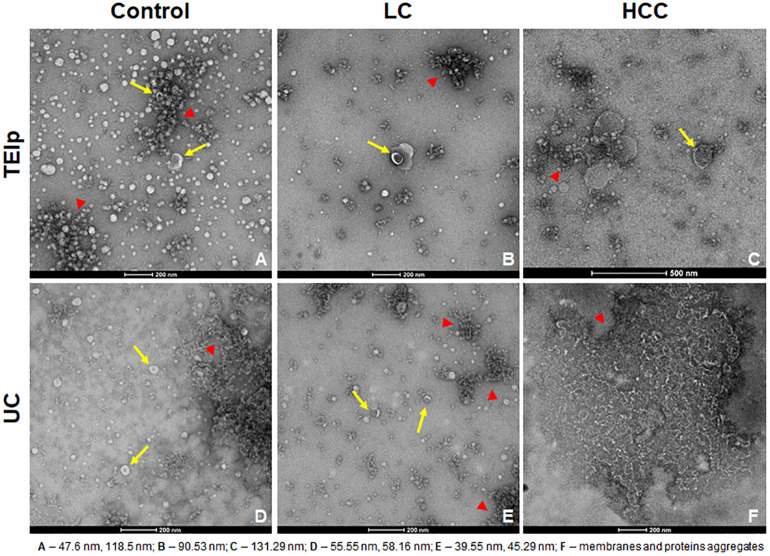
Gallery of negative stain digital micrographs showing cup-shaped exosomes with size ranging in between 40 and 150 nm (yellow arrows) and lipoprotein contamination (red triangles) in samples isolated from patients plasma by TEIp kit (A–C) or UC (D–F).